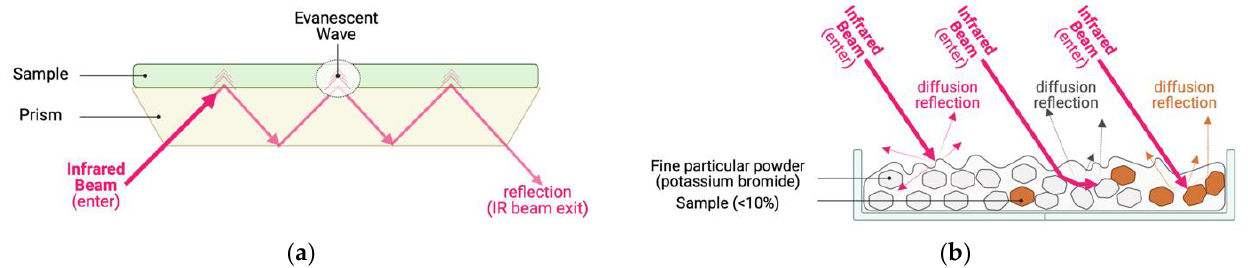
Figure 3. Schematic diagram of various measurement modes: ( a ) Fourier transform infrared spec- troscopy with attenuated total reflection (ATR-FTIRS); ( b ) Diffuse Reflectance Infrared Fourier Transform Spectroscopy (DRIFTS).